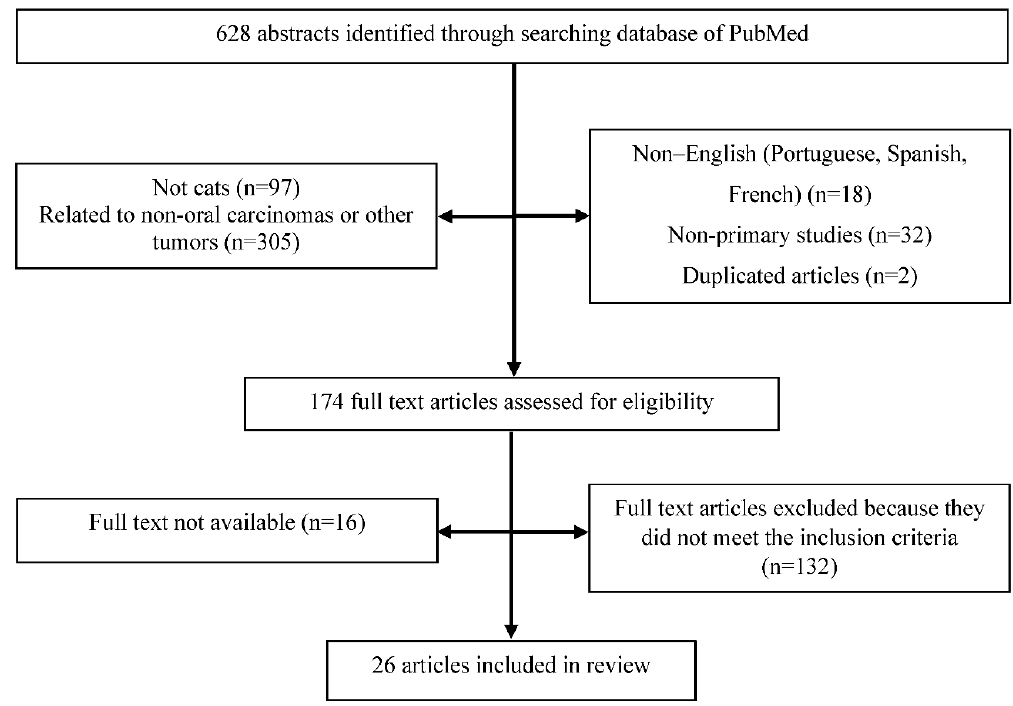
Figure 1. PRISMA flow chart for study selection.